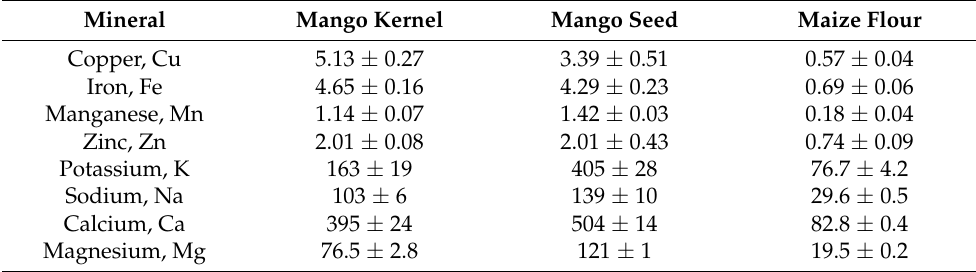
expressed as mean ±